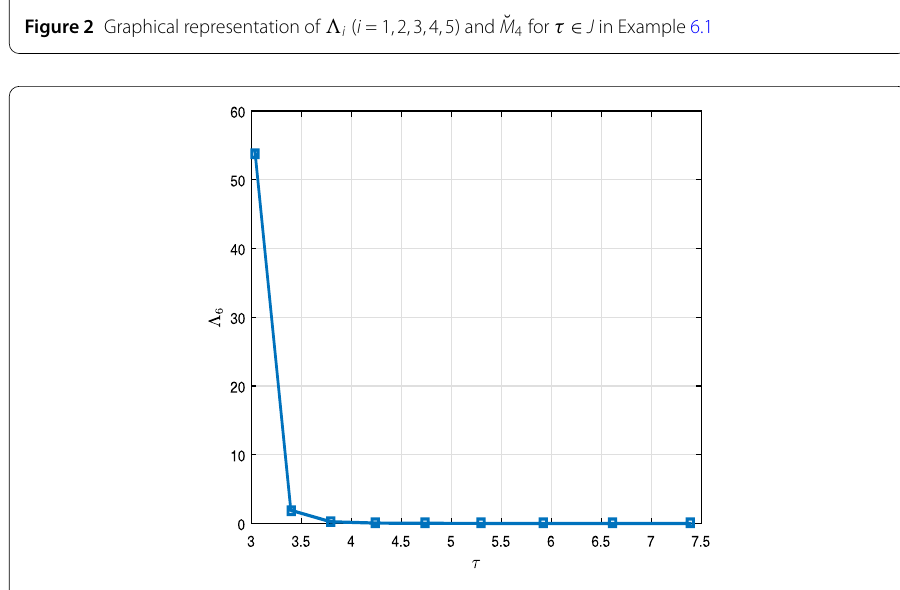
Figure 3 2D-graph of (cid:19) 6 for τ ∈ J in Example